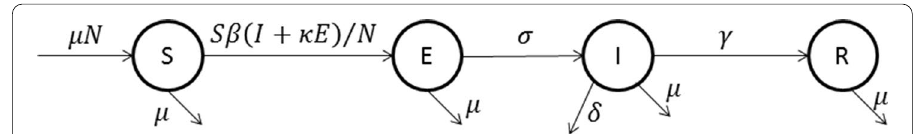
Fig. 1 The latent infection SEIR model flow